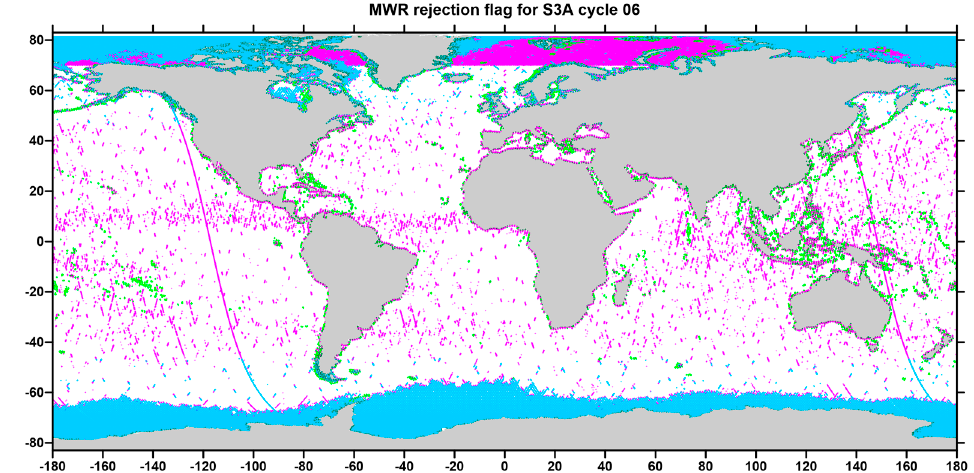
Figure 2. Sentinel ‐ 3A (S3A) points for cycle 06 with invalid microwave radiometer (MWR) observations: green—land contamination; blue—ice contamination; pink—rain, outliers, or green—land contamination; blue—ice contamination; pink—rain, outliers, or additional condition such additional condition such as all points above latitude 70°N or below 70°S. as all points above latitude 70 ◦ N or below 70 ◦